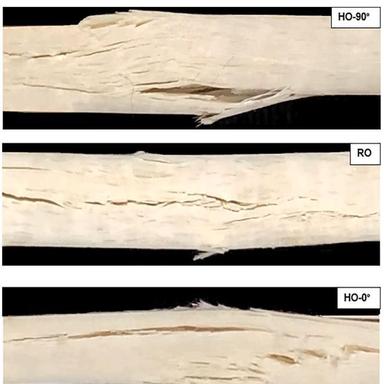
Macroscopic fracture behavior of HO-A-SMC and RO-A-SMC composites under quasi-static compression loading.